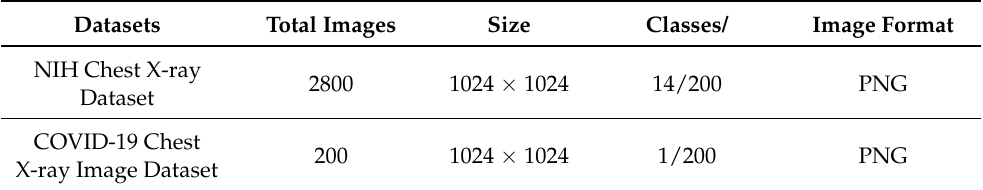
Table 2. NIH chest X-ray and COVID-19 chest X-ray image